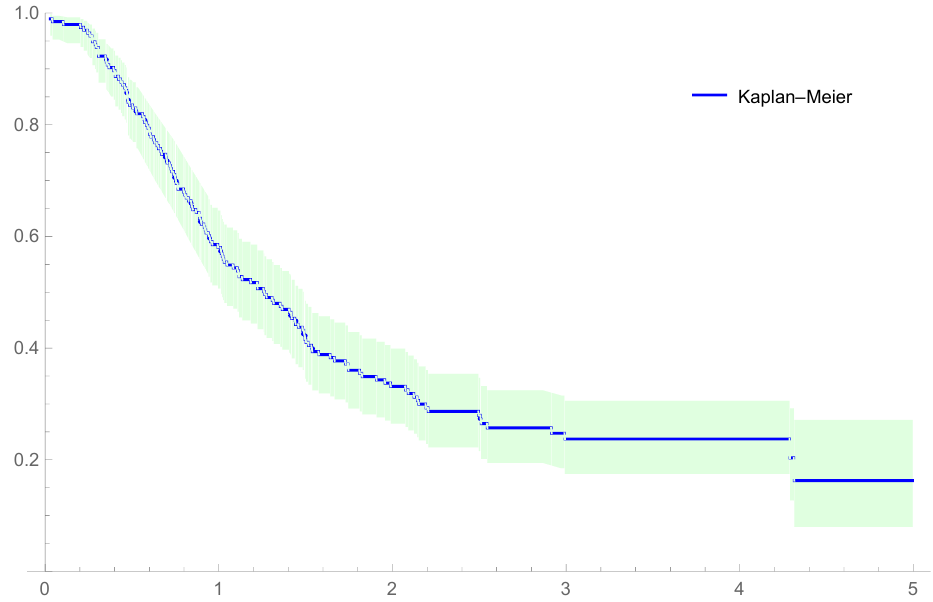
Figure 7. Kaplan–Meier curve for the oropharynx